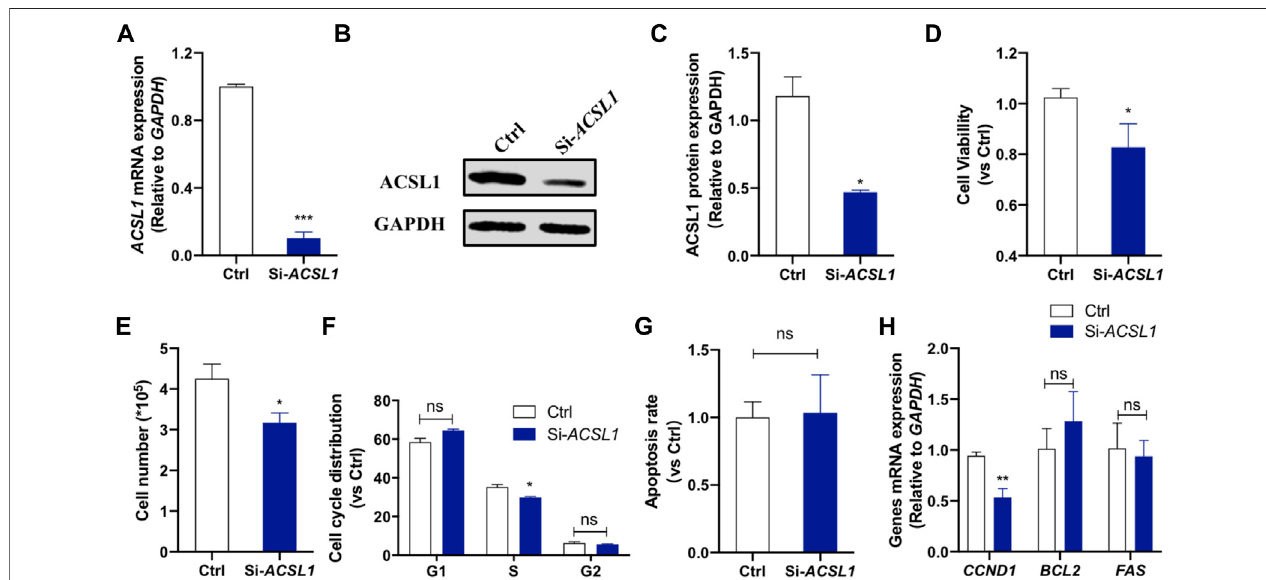
FIGURE 3 | ACSL1 interference inhibited mammary epithelial cell growth. (A) MAC-T cells were transfected with si- ACSL1 , and fl uorescence quantitative qPCR was used to detect the ACSL1 mRNA levels; (B,C) Western Blot detected the protein expression of ACSL1 ; (D) CCK-8 assays were applied to check the cell viability after ACSL1 knockdown; (E) Livingcellnumberincontrol(Ctrl)and ACSL1 knockdown(Si- ACSL1 )groups; (F) Flowcytometrywasusedtodetectcellcycleprogression; (G) Quanti fi cation ofapoptosis by fl owcytometry; (H) mRNA expression ofcellcycle and cellapoptosis – related genes. GAPDH wasused astheinner control;* p < 0.05, ** p < 0.01, and *** p < 0.001, ns: nonsigni fi cant difference. ACSL1 overexpression was then performed to con fi rm its regulatory role on mammary epithelial cell growthbyusing ACSL1 -overexpressingplasmid(pcDNA3.1- ACSL1 ).Transfectionof ACSL1 -overexpressingplasmidsigni fi cantlyincreased ACSL1 mRNA( Figure4A ) and protein abundance ( Figures 4B,C ). The CCK-8 assay showed that ACSL1 overexpression resulted in a signi fi cant promotion in cell viability ( p < 0.01) ( Figure 4D ). The cell counting test showed that MAC-T cells were signi fi cantly increased after ACSL1 overexpression ( p < 0.01) ( Figure 4E ). Then, fl ow cytometric analysis demonstrated a signi fi cant difference in cell cycle distribution in ACSL1 overexpression cells ( p > 0.05) ( Figure 4F ). The cell apoptosis rate showed no signi fi cant differences between the control and ACSL1 overexpression cells ( Figure 4G ). The overexpression of ACSL1 upregulated CCND1 expression ( p < 0.01), while that of BCL2 and FAS remained unchanged ( Figure 4H